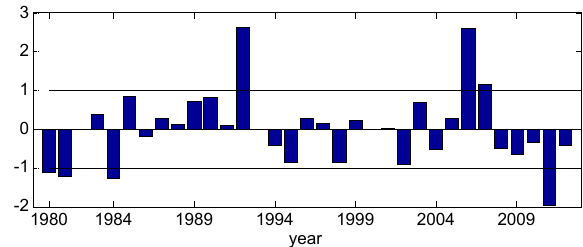
Figure 6. Standardized number of haze-fog days from 1980 to 2012.